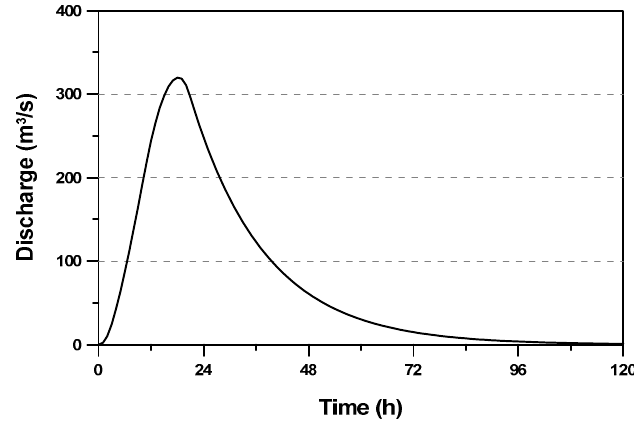
Figure 4. One-hour unit hydrograph of the Peace Dam basin derived by applying the Clark watershed routing method.